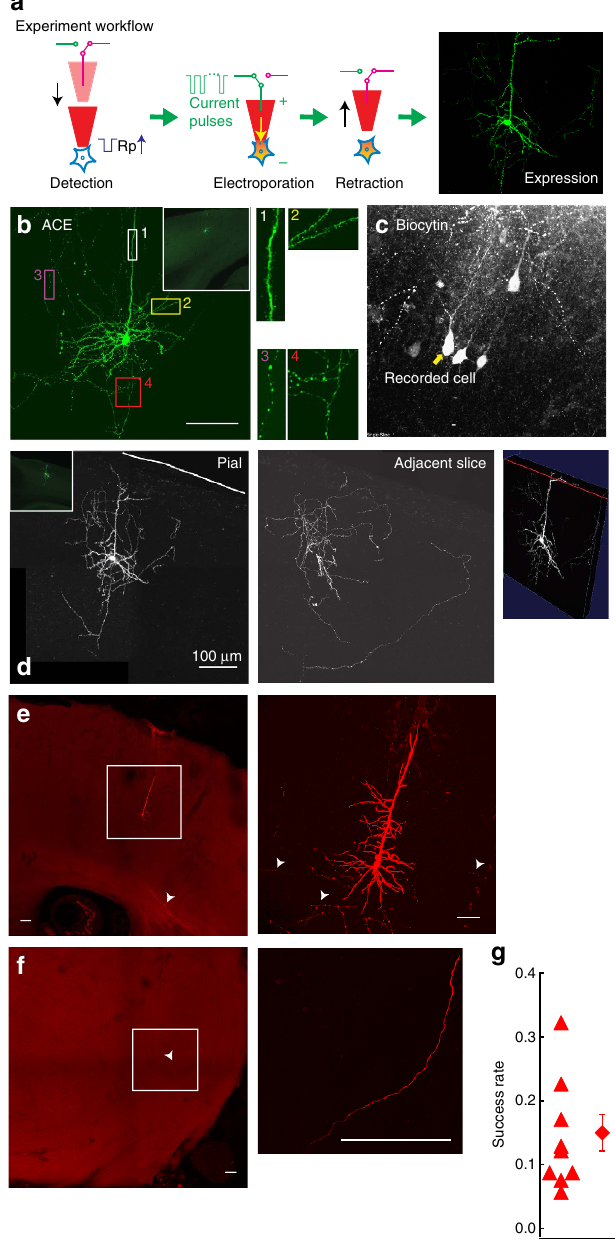
in vivo . A 10 (cid:3) , 0.4 NA dry objective was used to take image stacks for left figure panels of e and f . (Right panels) show the regions within the white boxes in e and f , respectively. In this neuron the axon can be traced B 4.0mm posteriorly and 4.5mm ventrally ( f ) away from the fluorescence- positive soma. Arrow heads: projecting axons. ( g ) Experiment yield ( n ¼ 9 mice) is comparable to manual experiments. Scale bar: 100 m